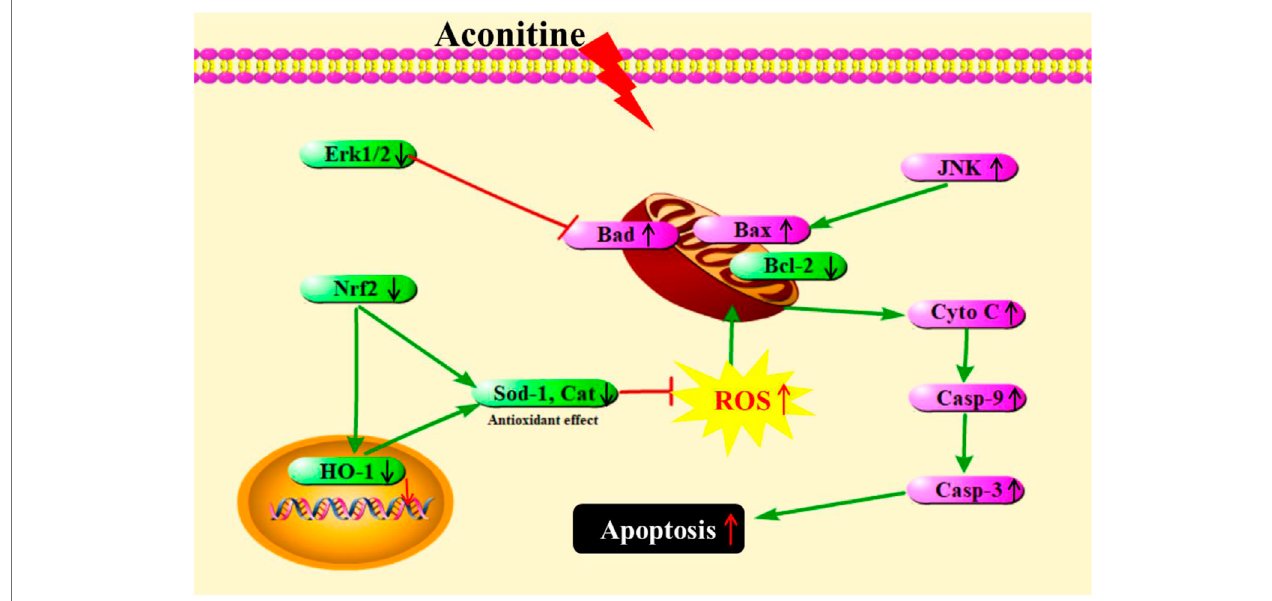
FIGURE 8 | A schematic representation showing AC-induced developmental toxicity in zebra fi sh embryos through ROS-medicated mitochondrial apoptosis involving Nrf2/HO-1 and JNK/Erk pathways.